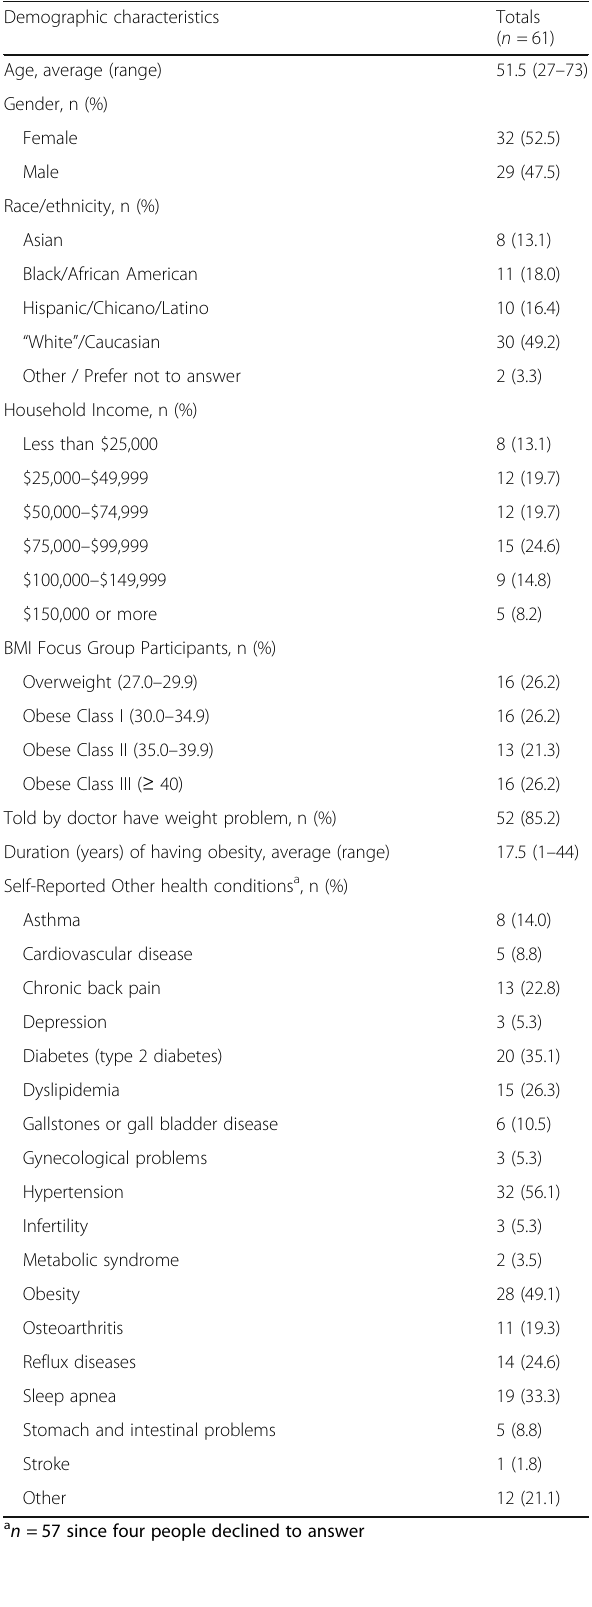
Table 1 Focus group participant demographic and